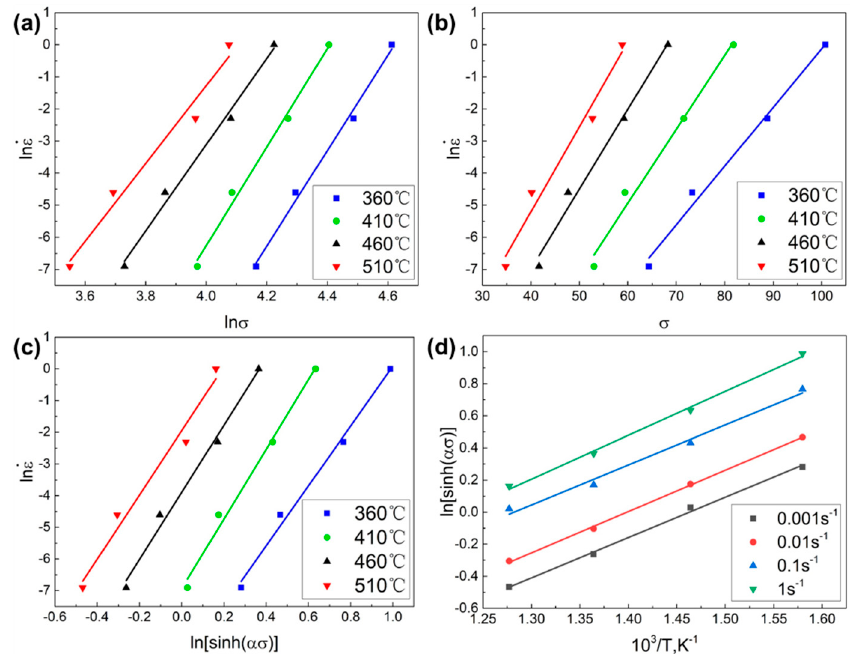
Figure 13. The relationship between the peak stress, strain rate and deformation temperature in the fifth layer of the deposited alloy: ( a ) ln ε ˙ ‐ ln σ s , ( b ) ln ε ˙ ‐ σ s , ( c ) ln ε ˙ ‐ ln[sinh( ασ )], ( d ) ln[sinh( ασ )] ‐ 1/T.